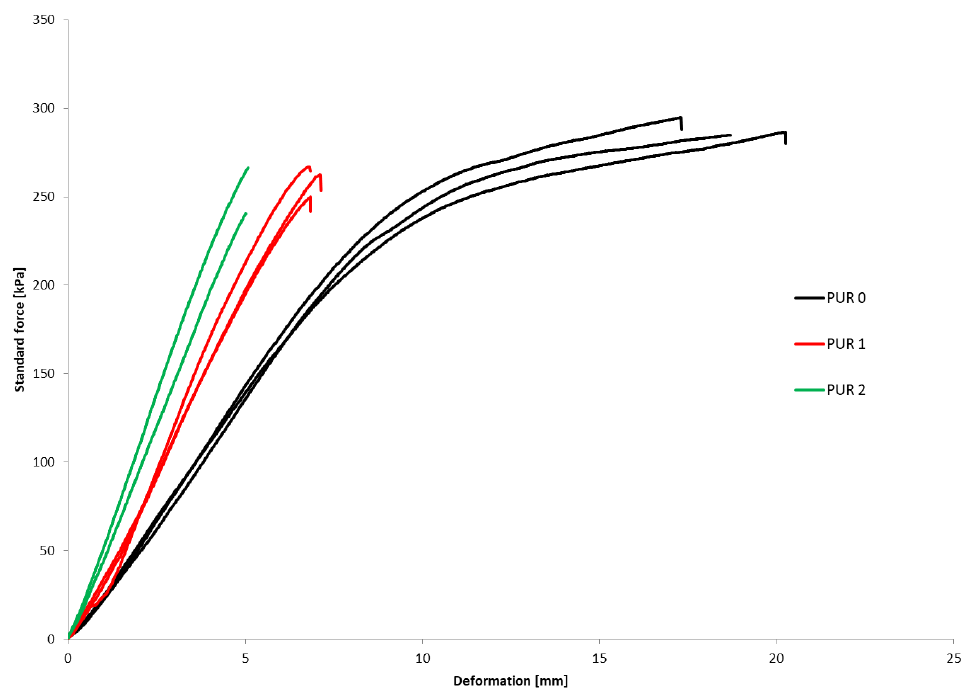
Figure 3. Bending behavior of samples PUR 0, PUR 1 and PUR 2.